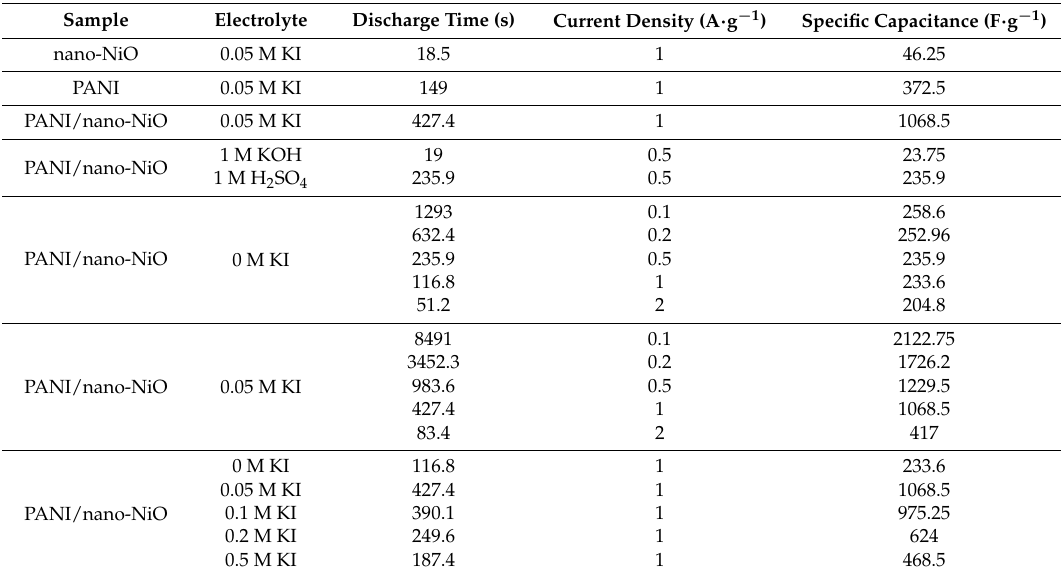
Table 1. The specific capacitances (F · g − 1 ) results.